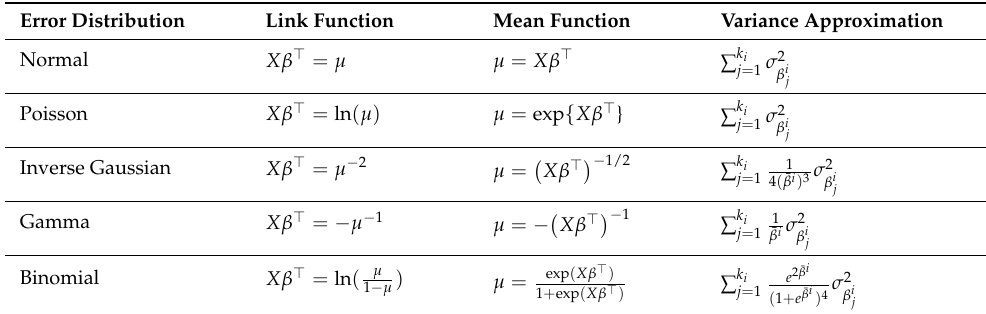
Table 2. Summary of the results of variance approximation of average coefficients, and their corre- sponding link function and mean function in generalized linear